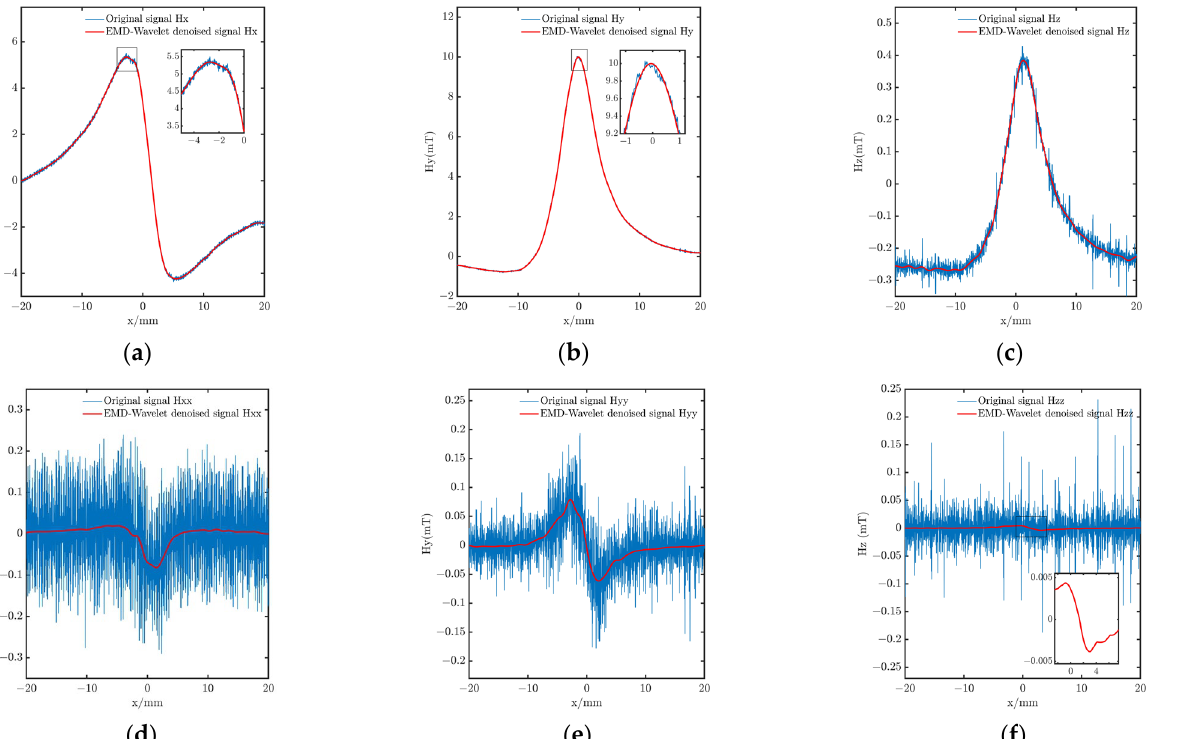
Table 1. Cross-correlation coefficient of IMF components of each magnetic field component signal.